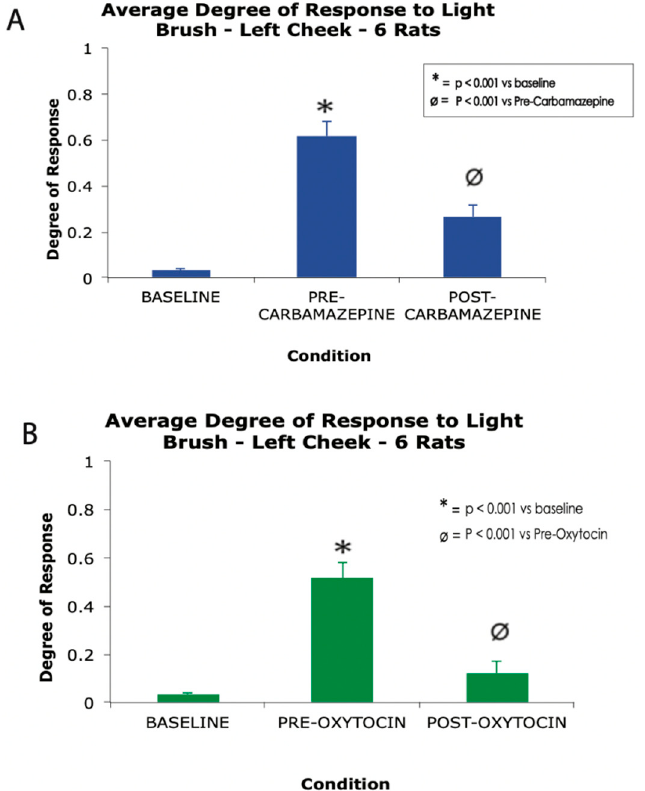
Figure 2. A high dose carbamazepine ( A ) and single dose of nasal oxytocin ( B ) produce robust analgesia in a rat model of trigeminal neuralgia. * p < 0.001 vs. baseline, Ø p < 0.001 vs. oxytocin, one-way ANOVA. Error bars represent standard error of the mean.